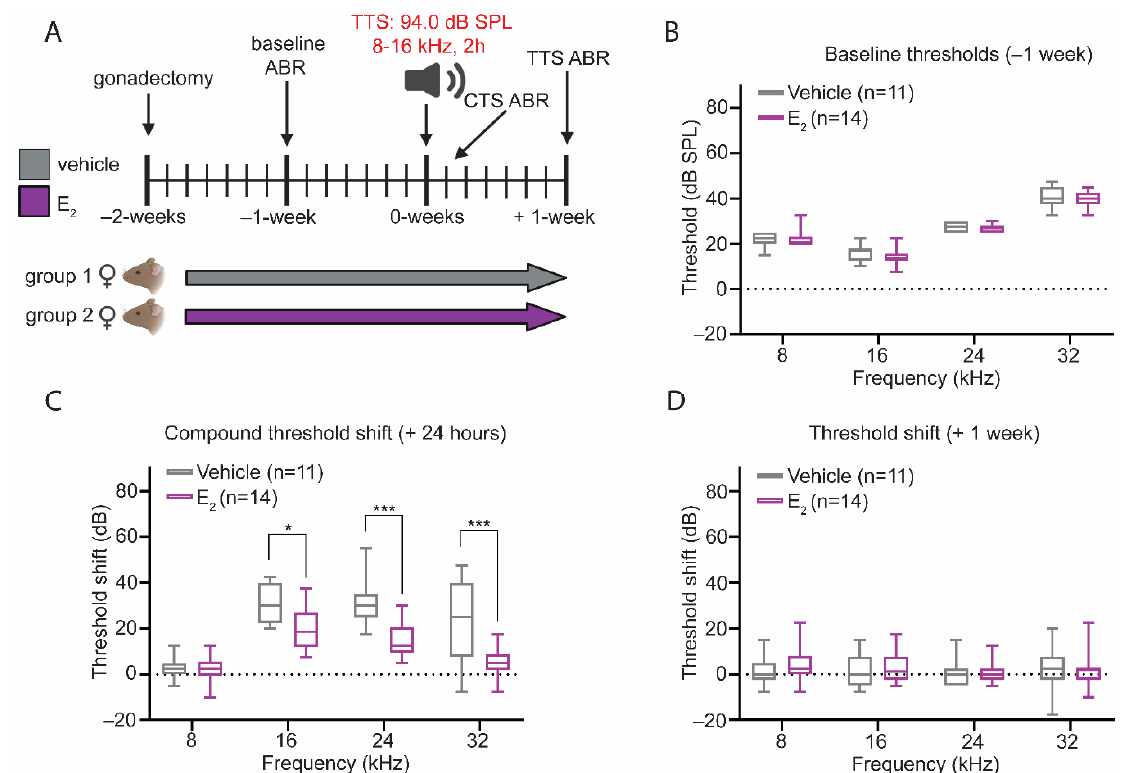
Figure 5. E 2 -replacement in gonadectomized female mice reduces the CTS after a temporary threshold shift (TTS)-inducing noise exposure. ( A ) Experimental schematic. Female mice were gonadectomized at 8-weeks of age and treated with vehicle or E 2 (150 µg/kg) beginning 2-days after the gonadectomy for the remaining duration of the study. Animals were exposed to a TTS-inducing noise (94 dB SPL, 8–16 kHz, 2-h) at 10-weeks of age. Auditory thresholds were quantified via ABR measurements 1-week pre-exposure (baseline), 24-h post-exposure (CTS), and 1-week post-exposure. ( B ) At baseline, vehicle-treated and E 2 -treated mice display no differences in ABR thresholds at any frequency tested. ( C ) E 2 -treated female mice display a reduced CTS at 16 kHz ( p = 0.0266), 24 kHz ( p = 0.0001), and 32 kHz ( p = 0.0001). ( D ) Despite the differences in the magnitude of the CTS, there are no differences in ABR thresholds 1-week post-exposure between the E 2 -treated and vehicle-treated female at any frequency tested. ABR thresholds were compared using a 2-way ANOVA followed by Tukey’s post-hoc test. n = number of mice; ABR thresholds: minimum value, 1st quartile, median, 3rd quartile, maximum value; * p < 0.05, *** p < 0.001.